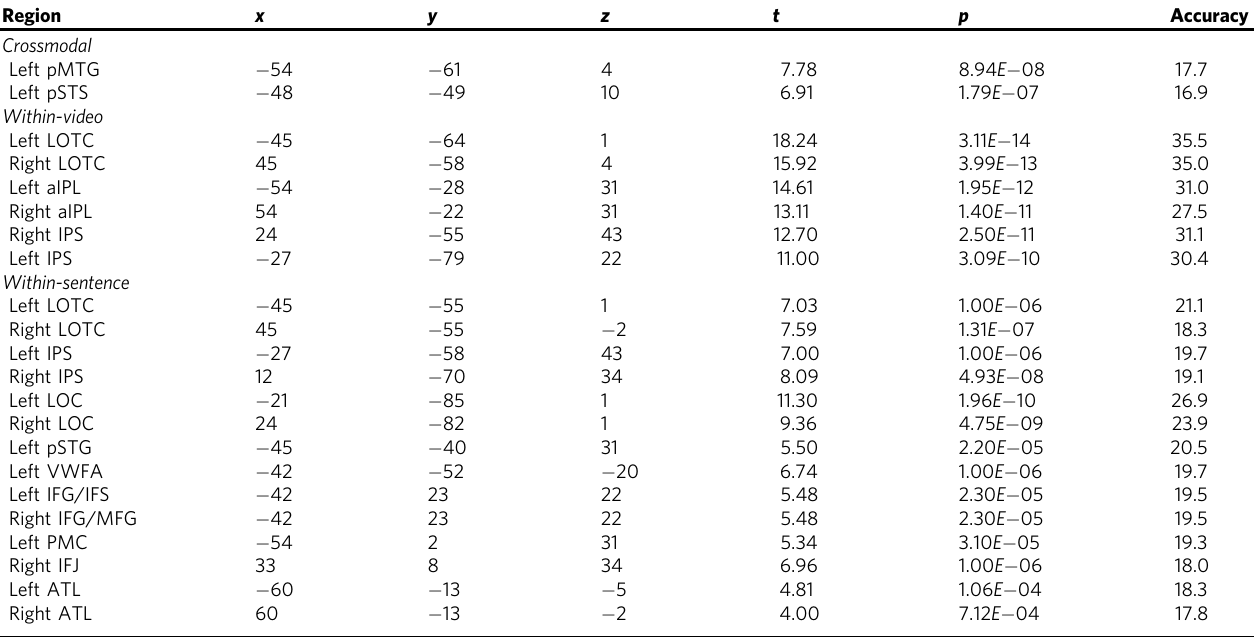
Table 1 Clusters identi fi ed in the crossmodal, within-sentence, and within-video action decoding Region x y z t p Accuracy